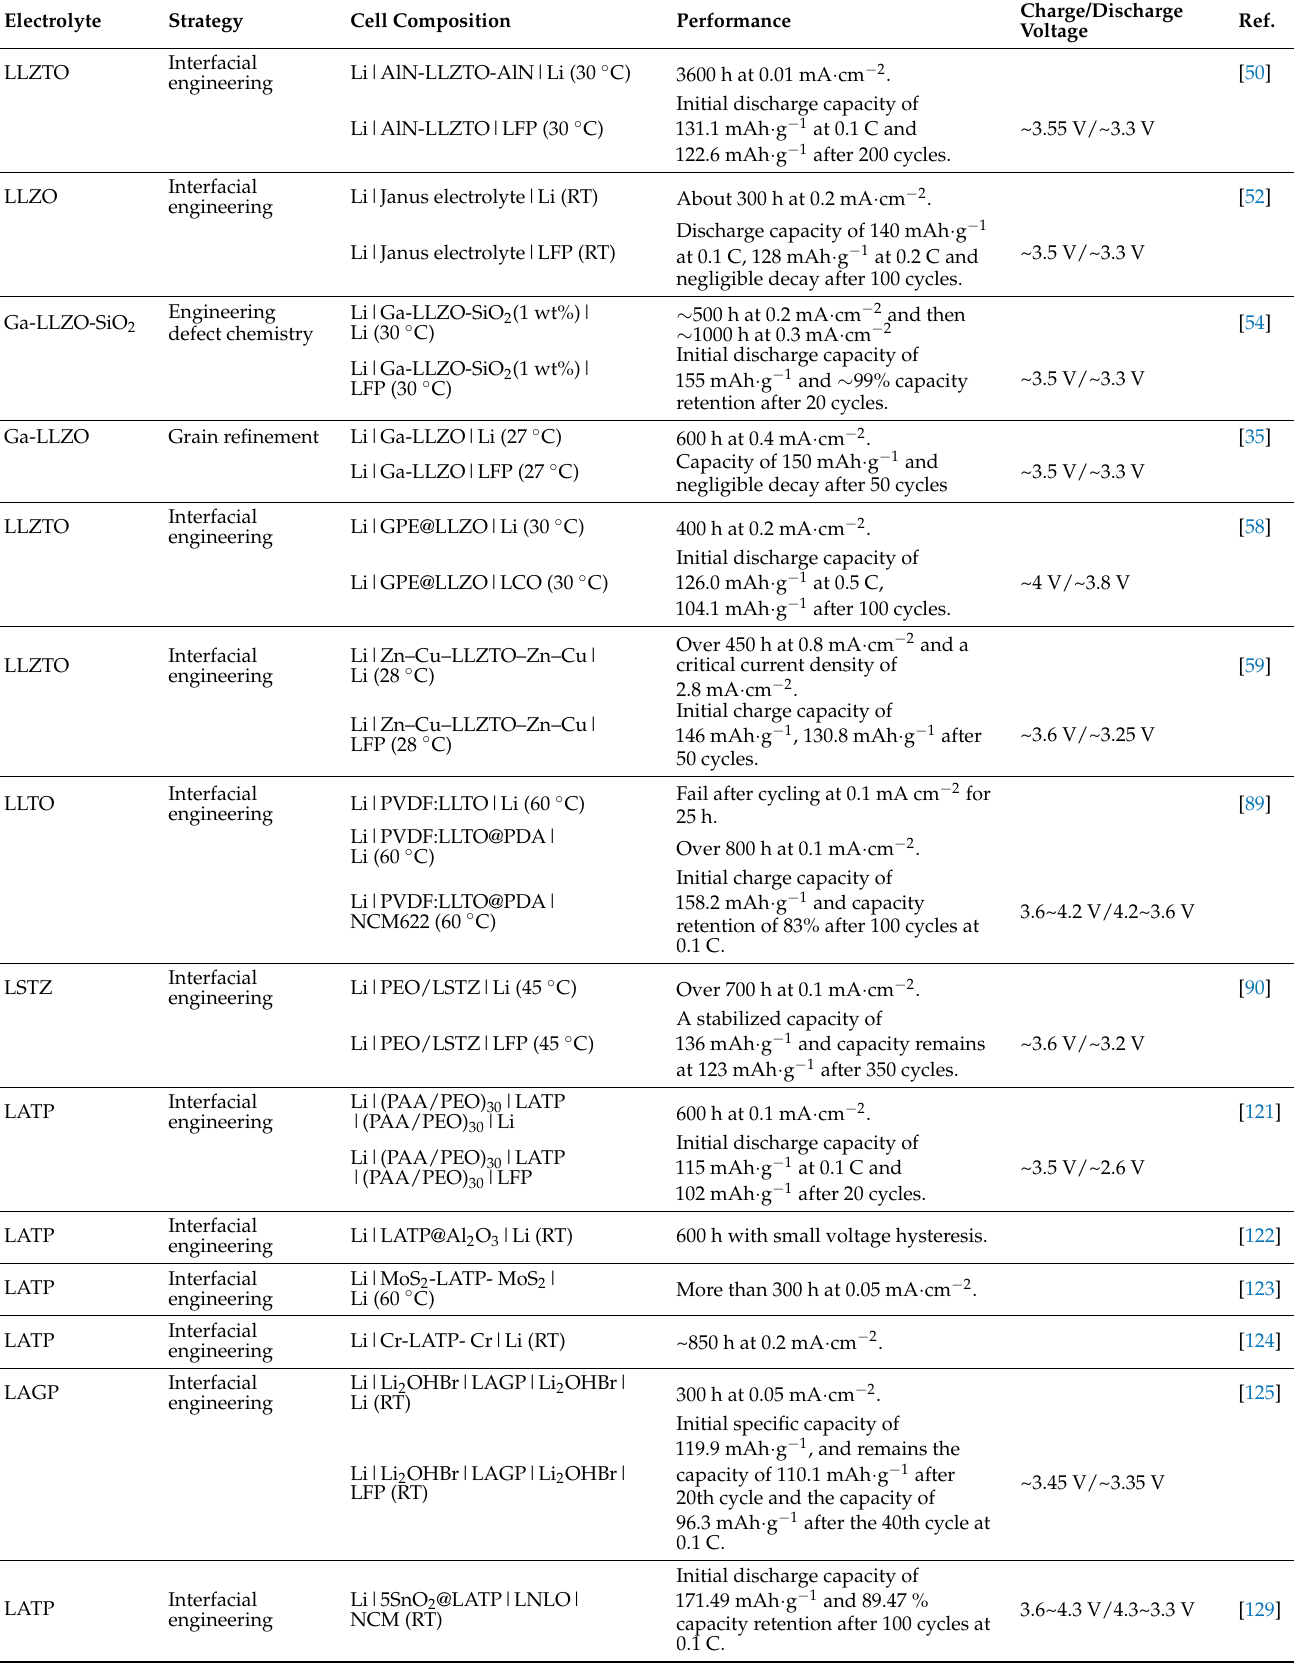
Table 2. Summary of performance of ASSLB assembled with